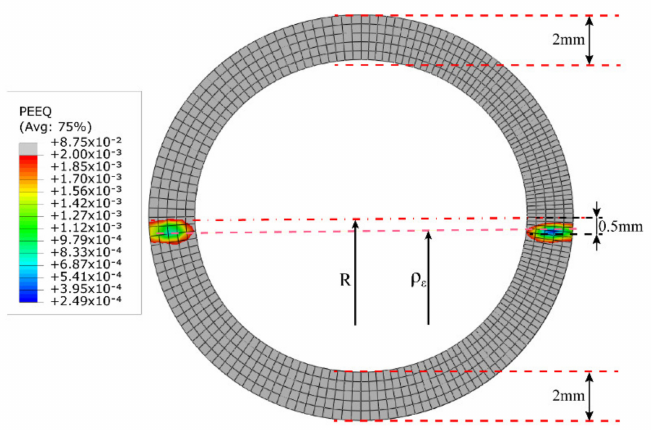
Figure 12. The position of the strain neutral layer ρ ε shown by SFEM when the bending radius R is 100 mm.